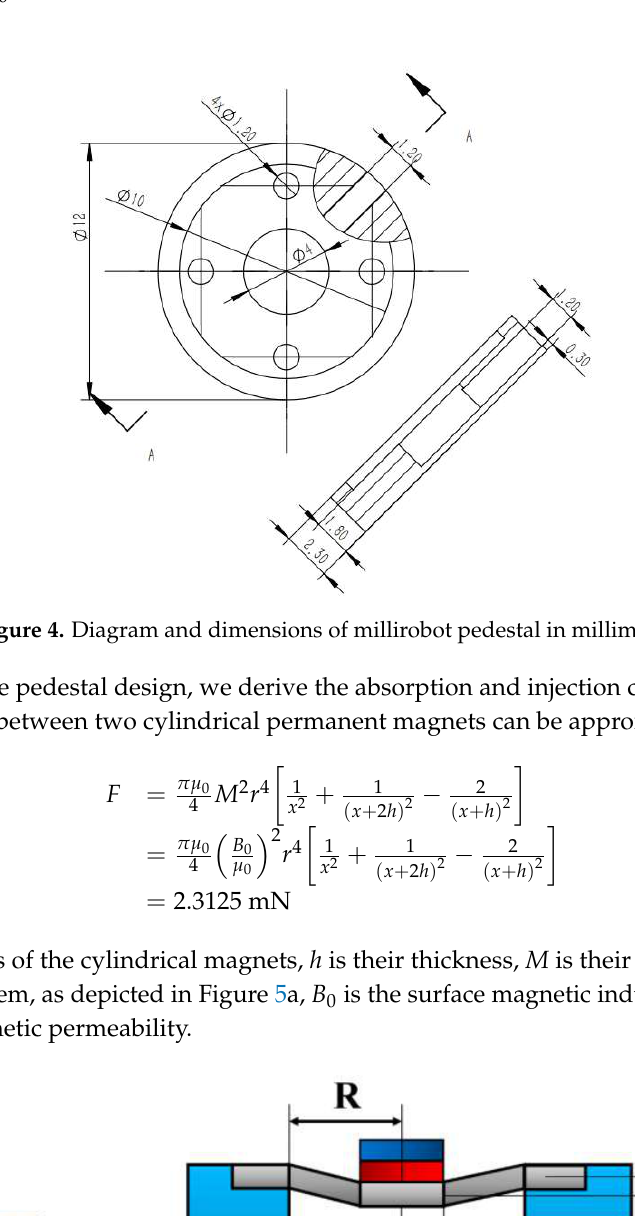
Figure 5. Diagram of employed permanent magnets and millirobot pedestal. ( a ) Parameters to determine the magnetic force between two cylindrical permanent magnets, ( b ) parameters to determine the hollow volume variation.